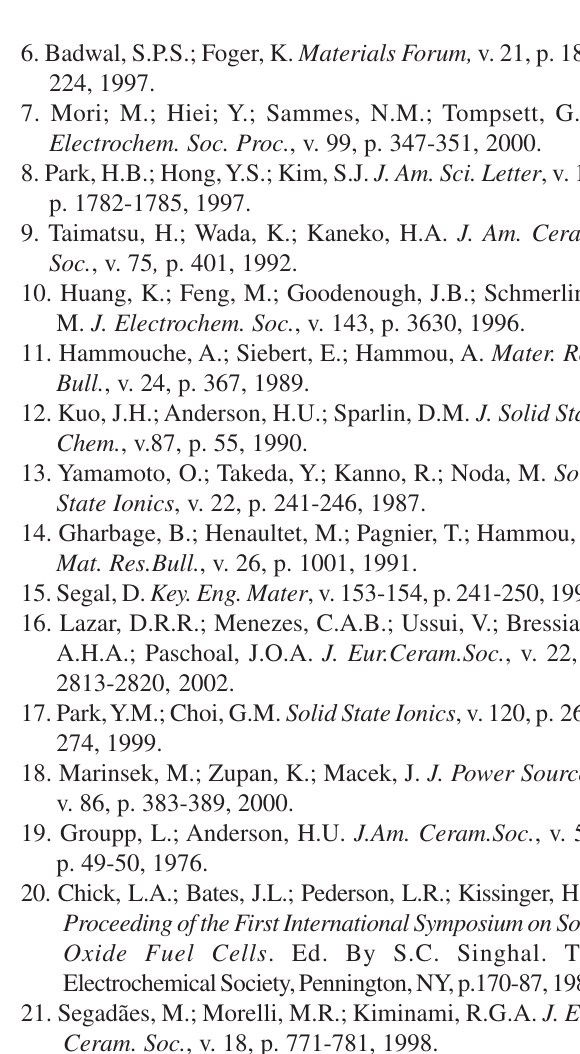
Figure 7. SEM micrographs of the polished and thermally etched surfaces of the samples obtained from LaCr sized by conventional mechanical mixing (a); combustion reaction process